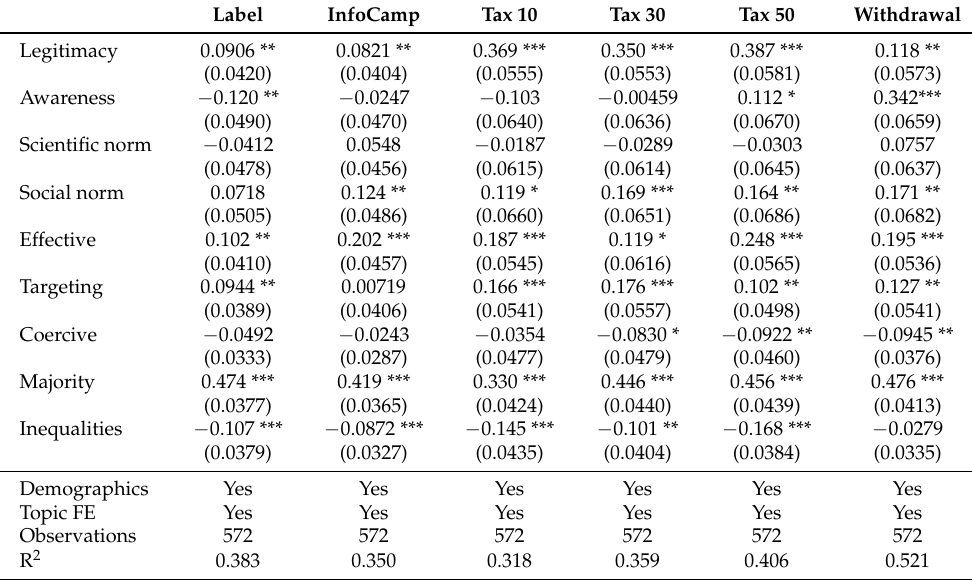
Table A4. Regression of policy acceptability scores by